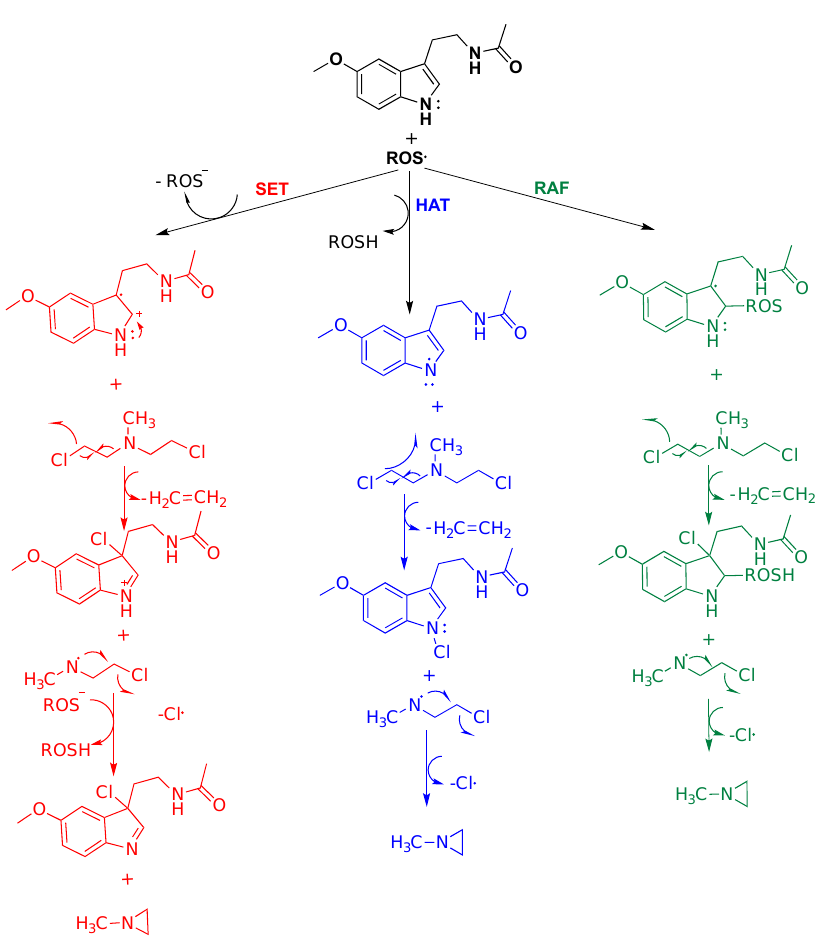
Scheme 1. Three alternative free radical-mediated mechanisms for quenching the nitrogen mustard toxic agent exerted by melatonin.